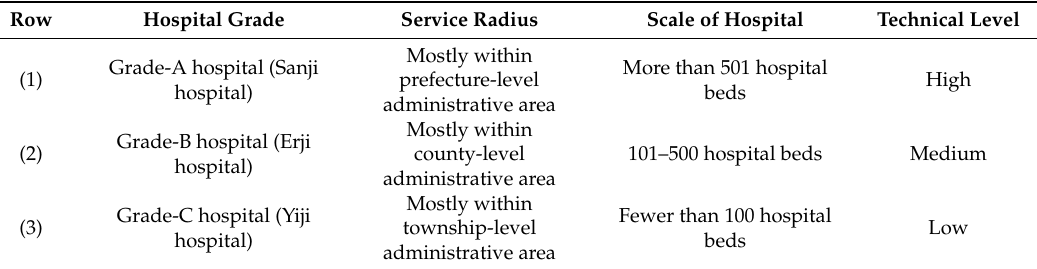
Table 1. Descriptive characteristics of hospitals in